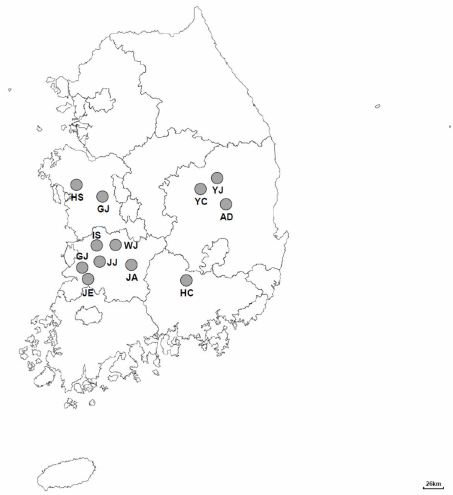
Figure 1. A map of the Republic of Korea showing the location of the sampling sites from where fecal samples were collected from Korean native calves. GJ: Gimje ( n = 624); JE: Jeongeup ( n = 97); YJ: Youngju ( n = 19); IS: Iksan ( n = 14); GJ: Gongju ( n = 13); HS: Hongseong ( n = 7); HC: Hapcheon ( n = 6); JJ: Jeonju ( n = 3); AD: Andong ( n = 3); WJ: Wanju ( n = 2); JA: Jinan ( n = 2); YC: Yecheon ( n =